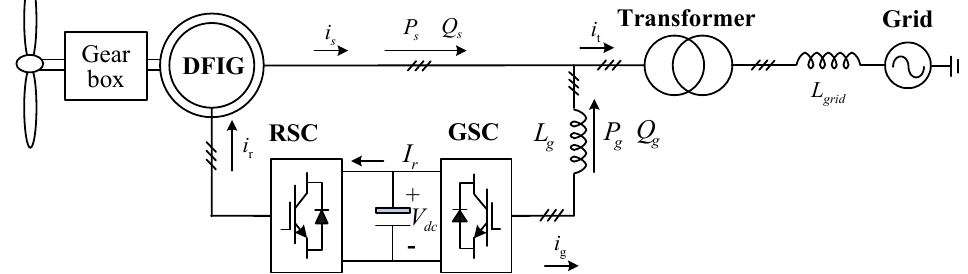
Figure 1. Schematic diagram of a DFIG-based (doubly-fed induction generator) wind power system. RSC: rotor-side converter; GSC: grid-side converter.